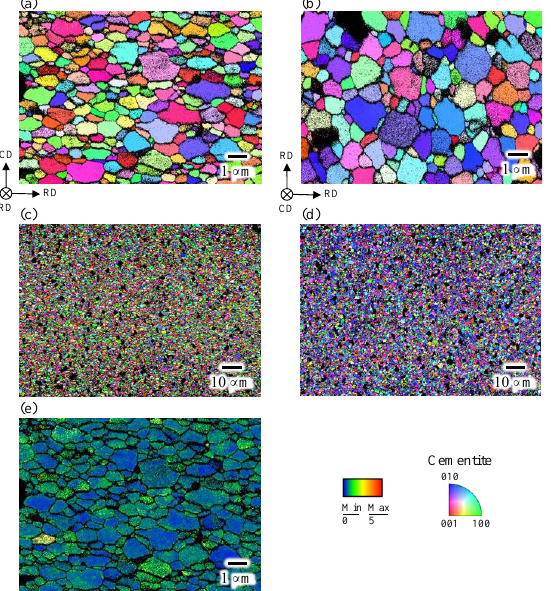
Figure 6 . IPF maps of the compressed sample in ( a , c ) CD-RD and ( b , d ) RD-RD plains. ( e ) KAM maps.